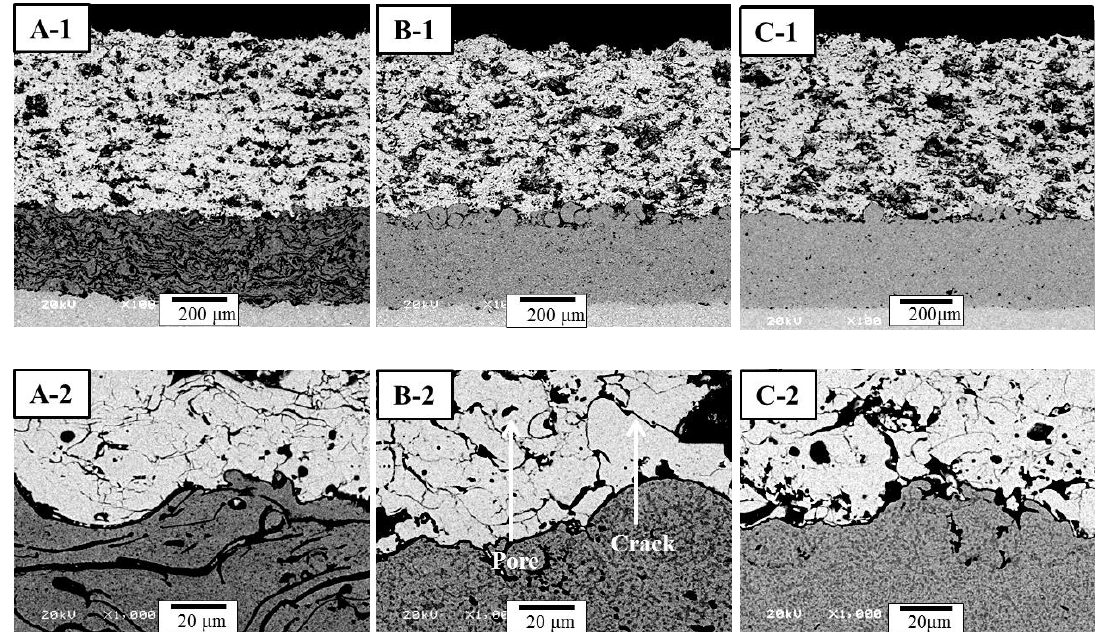
Figure 3. Cross-sectional microstructures of TBCs after FTF tests for 1429 cycles: ( A ) TBC with APS bond coat; ( B ) TBC with HVOF bond coat; and ( C ) TBC with LPPS bond coat. Each number indicates the overall and interface microstructures,